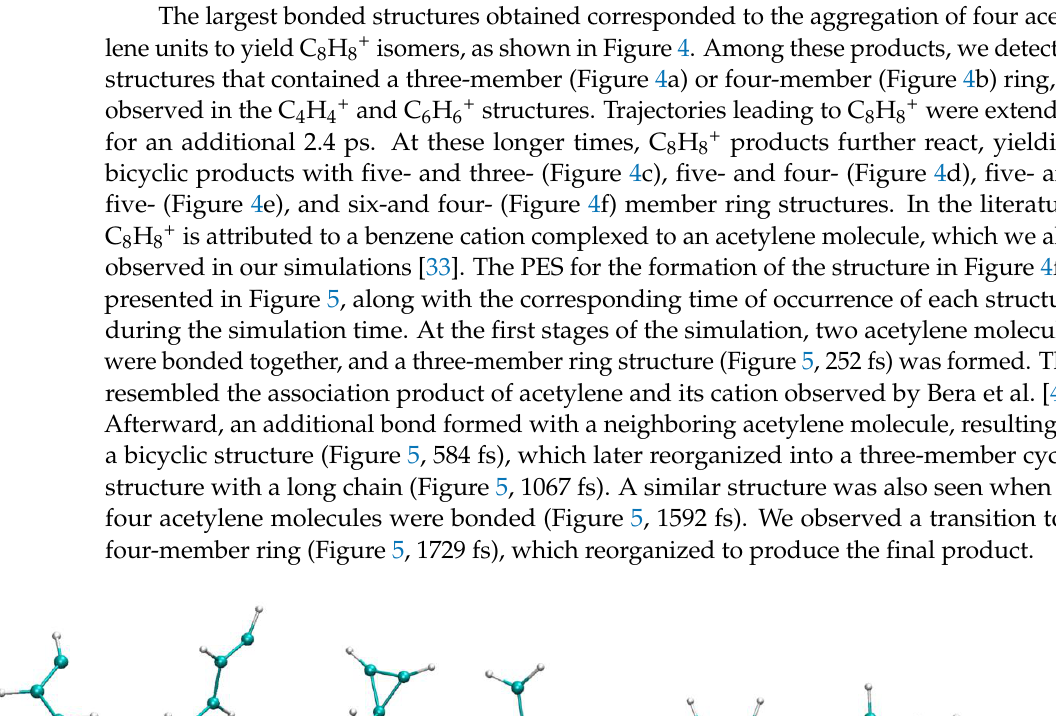
Molecules 2021 , 26 , x FOR PEER REVIEW